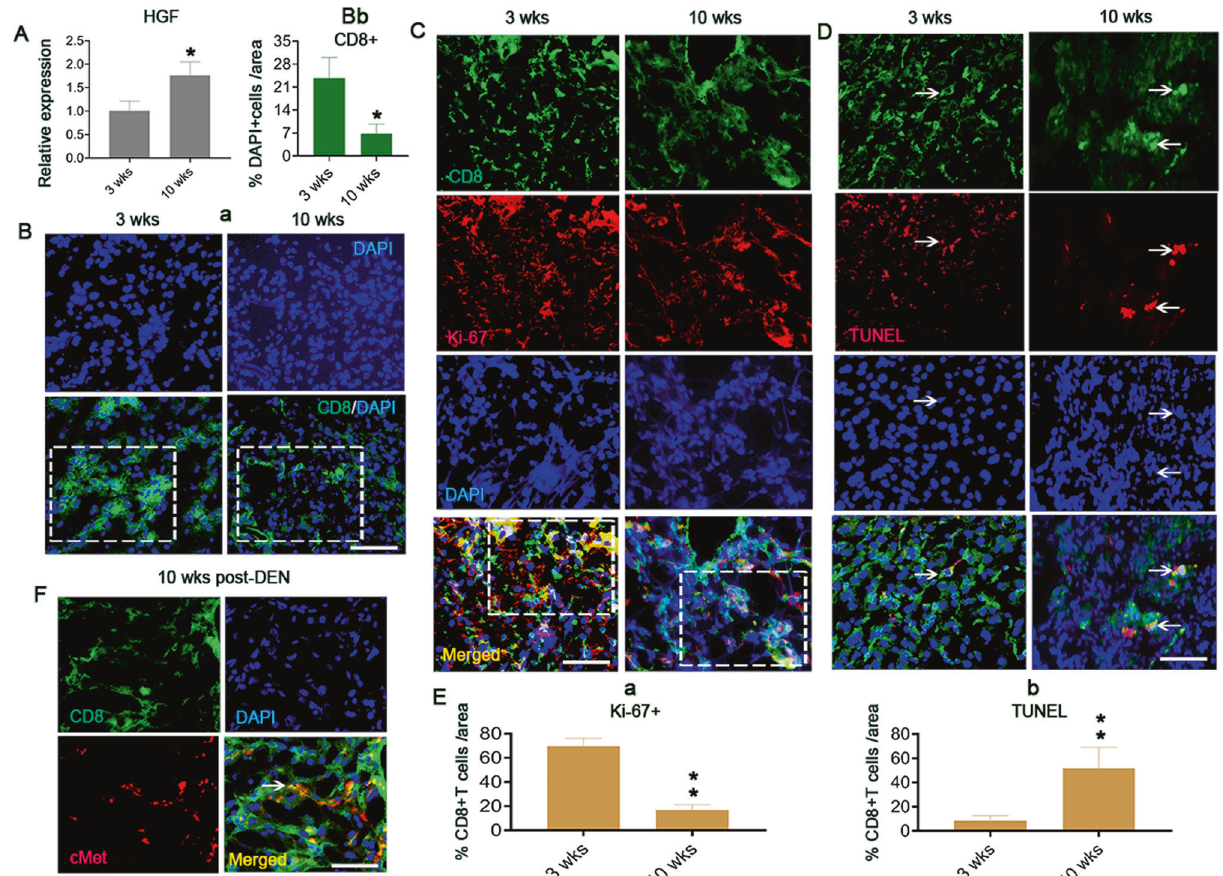
Fig. 1 Higher HGF secretion induces CD8 + T cell apoptosis in the liver cirrhotic period (LCP) of DEN-induced liver fi brosis/cirrhosis mouse model. A qRT ‒ PCR assay of HGF expression in the liver tissues at 3 and 10 weeks post-DEN, n = 3. B (a, b) Immuno fl uorescence staining for the percentage of CD8 + T cells with liver tissue-resident (DAPI + ) cells at 3 and 10 weeks post-DEN (a, green, boxes) and quanti fi cation (b). Scale bar = 200 µM, n = 6. C , D Double immuno fl uorescence staining of Ki-67 (red, C ) and TUNEL (red, D ) within CD8 + T cells (green) in the diseased liver tissues at 3 and 10 weeks post-DEN (brown color after merging in boxes, C , D ). Scale bar = 200 µM, n = 6/staining marker. E (a, b) Quanti fi cation of the counts in C and D . F Double immuno fl uorescence staining of c-Met (red) and CD8 (green) in liver tissues at 10 weeks post-DEN. The arrow marks c-Met-expressing CD8 + T cells (brown). Scale bar = 200 µM, n = 6. At least three independent experiments were performed, and the data are presented as the means ± SDs; * p < 0.05 and * p < 0.001 vs. 10 weeks post-DEN (Student ’ s t